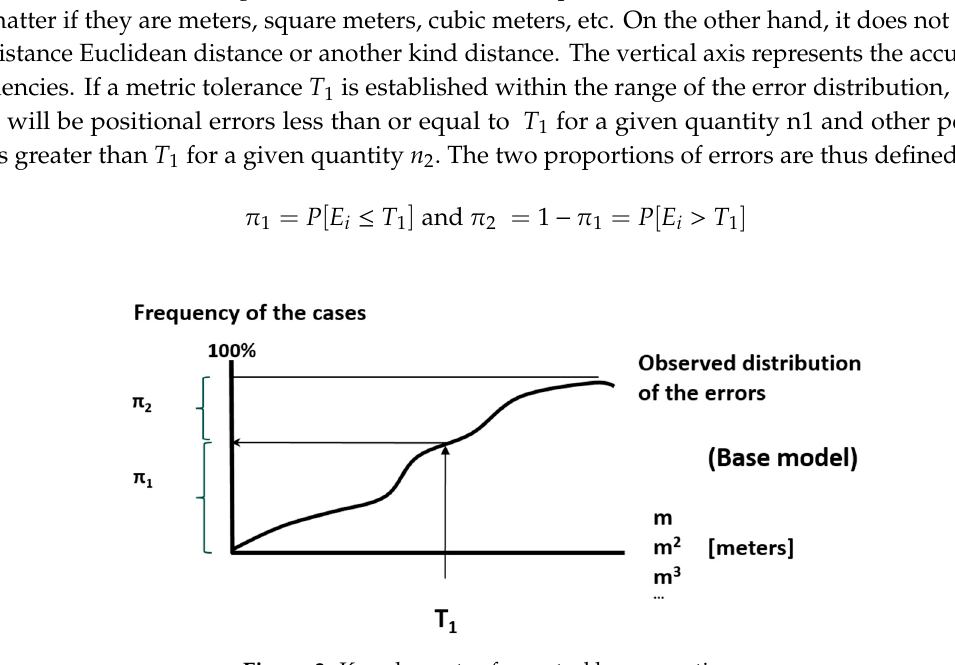
( b ) Figure 4. Conceptual example of a control by proportions: 2 tolerances ( a ) and three tolerances ( b ).